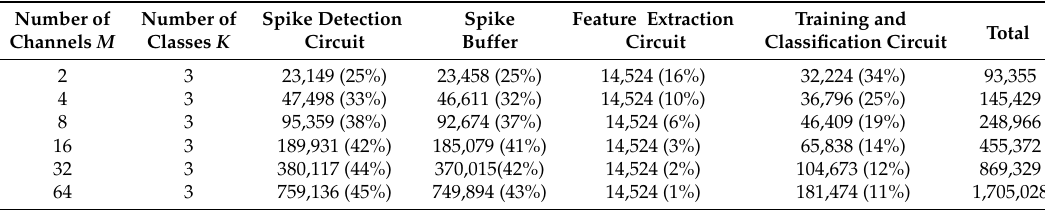
Table 5. The area ( µ m 2 ) of each component of the proposed circuit for different numbers of channels M